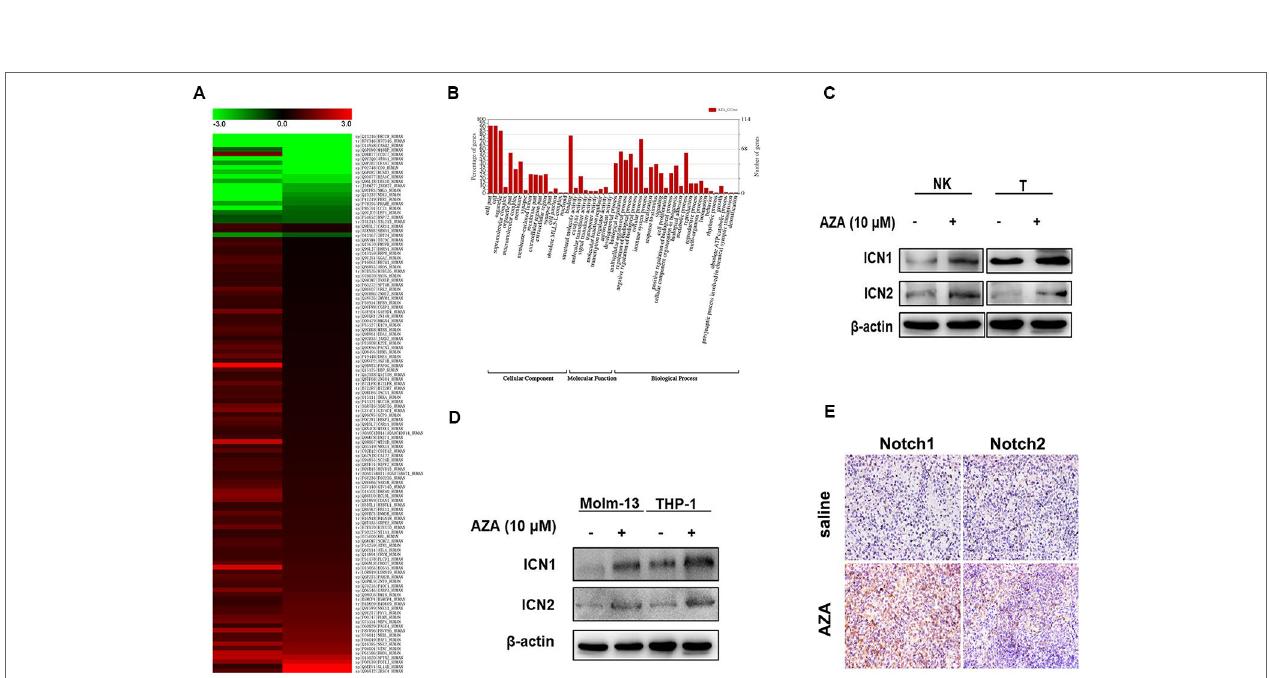
FIgUrE 5 | Notch was found up-regulated after azelaic acid (AZA) treatment. (A) 120 differential expressed proteins associated in 52 functions after AZA treatment by protein mass spectrometry analysis in the heat map. (B) GO annotation with 528 differential expressed proteins. (c, D) THP-1, Molm-13, NK, and T cells were treated with 10 μM AZA for 24 h, the expression level of ICN1 and ICN2 was validated by western blot. (E) The expression of Notch1 and Notch2 in mouse spleen measured by ICH. IHC,